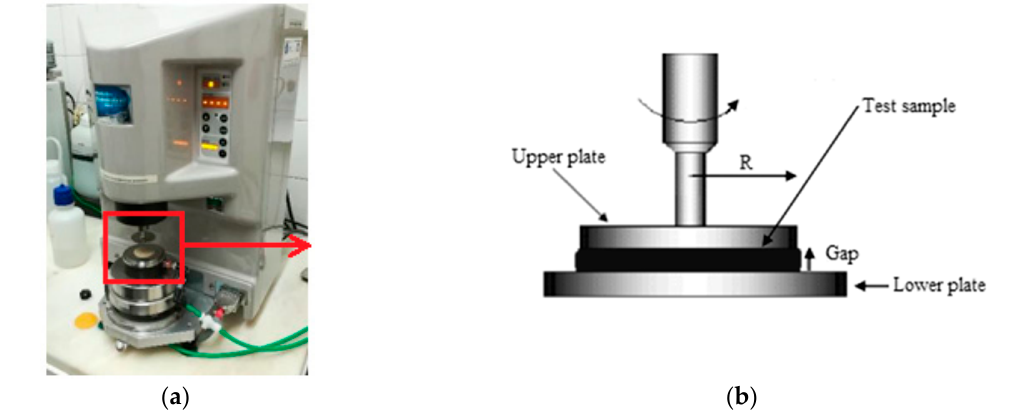
Figure 5. Rheometer: ( a ) Rotational rheometer; ( b ) Illustration of parallel plates geometry.